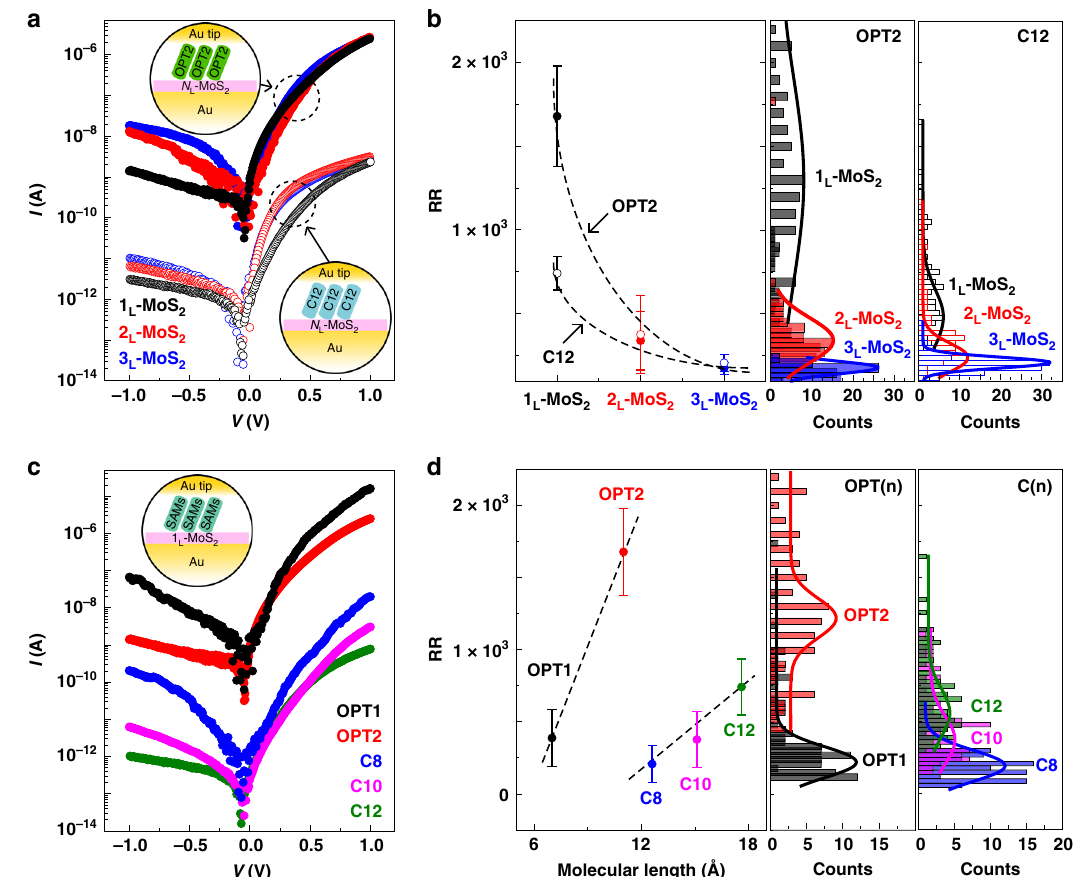
Fig. 3 Modulation of rectifying characteristics of the molecular heterojunctions. a Representative I - V characteristics for the Au/OPT2 (or C12)/ N L -MoS 2 ( N L = 1 L , 2 L , or 3 L )/Au junction. b RR plots of OPT2/ N L -MoS 2 and C12/ N L -MoS 2 junctions as a function of the number of MoS 2 layers. As the N L was increased from 1 to 3, the RR decreased from (1.68 ± 0.63) × 10 3 to (1.75 ± 0.35) × 10 2 for the OPT2/ N L -MoS 2 junction, and from (7.41 ± 1.00) × 10 2 to (2.07 ± 0.17) × 10 2 for the C12/ N L -MoS 2 junction. The statistical histograms of RR for OPT2/ N L -MoS 2 and C12/ N L -MoS 2 as a function of the number of MoS 2 layers are shown in the right fi gure. c Representative I - V characteristics for OPT( n ) ( n = 1 or 2)/1 L -MoS 2 and C( n ) ( n = 8, 10, or 12)/1 L -MoS 2 junctions. As n increased, the RR increased from (3.87 ± 1.95) × 10 2 to (1.68 ± 0.63) × 10 3 for OPT( n )/1 L -MoS 2 , and (2.08 ± 1.26) × 10 2 to (7.41± 1.00)× 10 2 for the C( n )/1 L -MoS 2 junction. d RR plots of OPT( n )/1 L -MoS 2 and C( n )/1 L -MoS 2 junctions as a function of the molecular length. The statistical histograms of RR for OPT( n )/1 L -MoS 2 ( n = 1 and 2) and C( n )/1 L -MoS 2 ( n = 8, 10, and 12) junctions are shown in the right fi gure. The error bars in ( b ) and ( d ) indicate the standard deviations of RR obtained from at least 100 different positions of each junction. Note that the molecular length for each molecule is 0.7 (OPT1), 1.1 (OPT2), 1.26 (C8), 1.51 (C10), and 1.76 nm (C12),